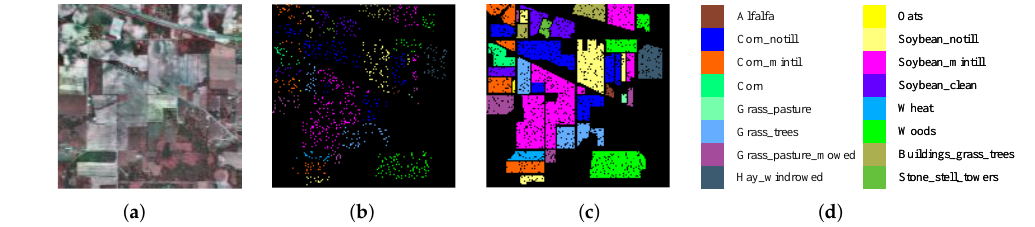
Figure 3. IP dataset. ( a ) Composite image. ( b ) Training set. ( c ) Test set. ( d ) Legend.